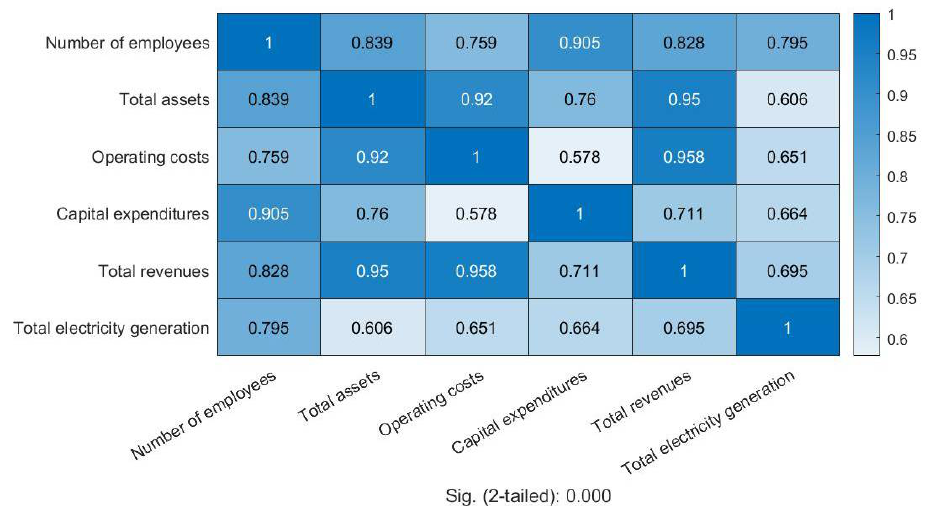
Figure 1. Pearson correlation pair coefficients between the selected inputs and outputs.